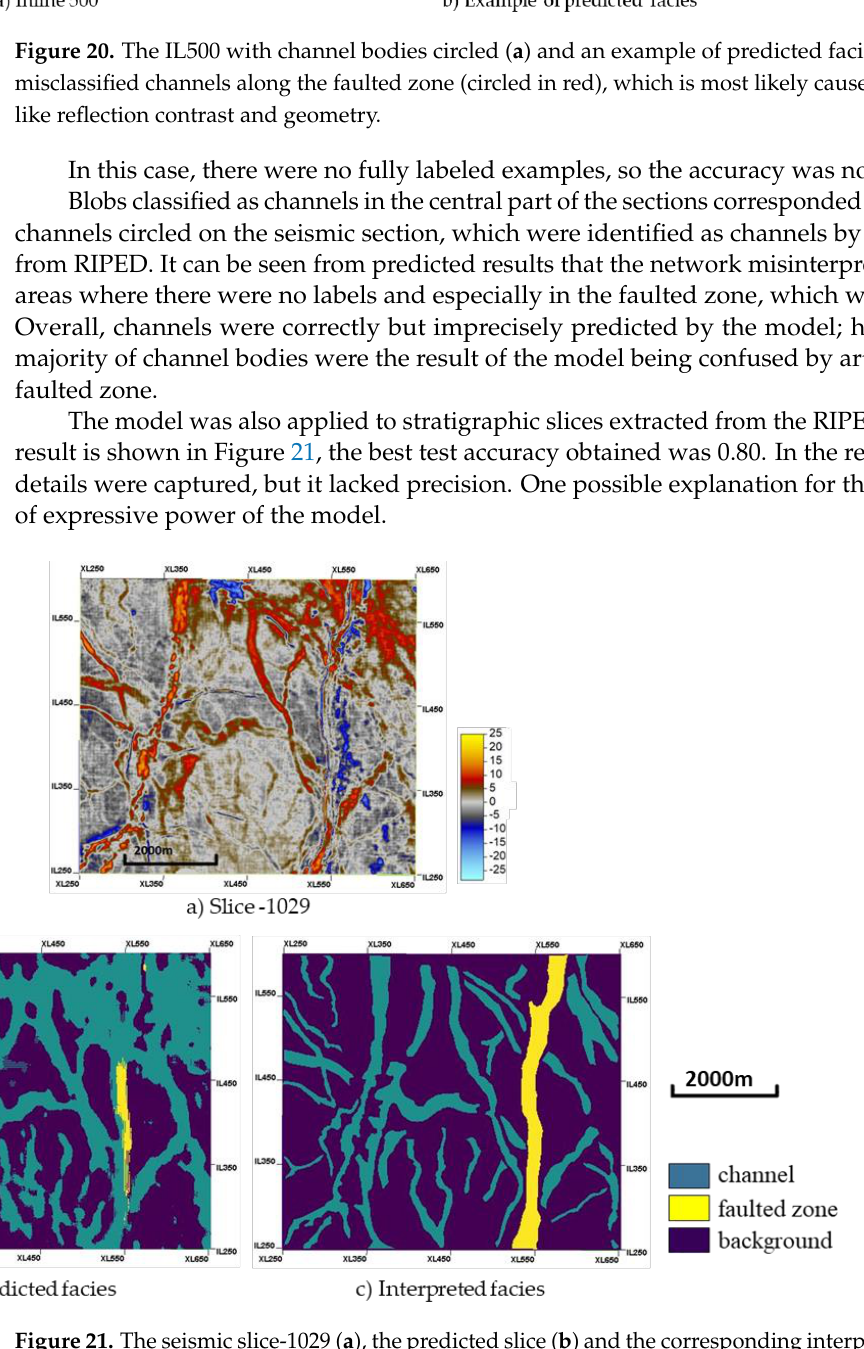
Figure 21. The seismic slice-1029 ( a ), the predicted slice ( b ) and the corresponding interpreted label ( c ). In the prediction, the key details are captured, but it is overall not very accurate.